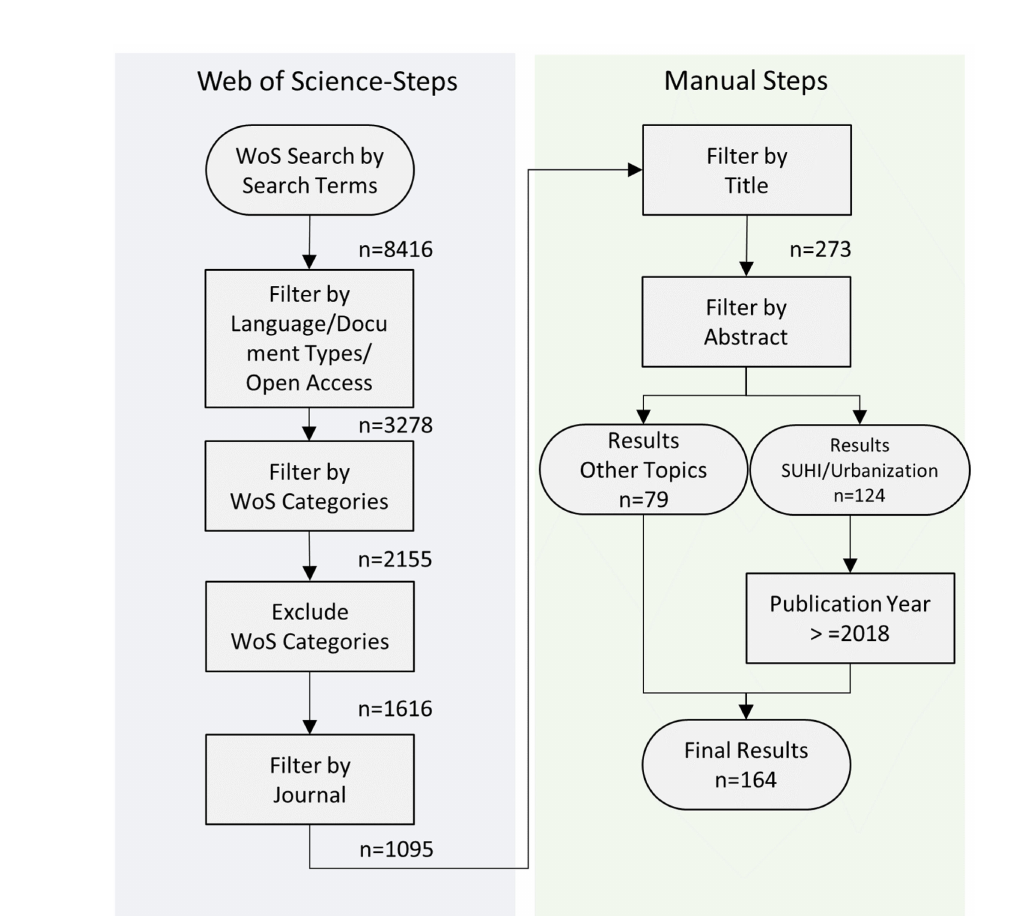
Figure 3. Flowchart of the literature selection